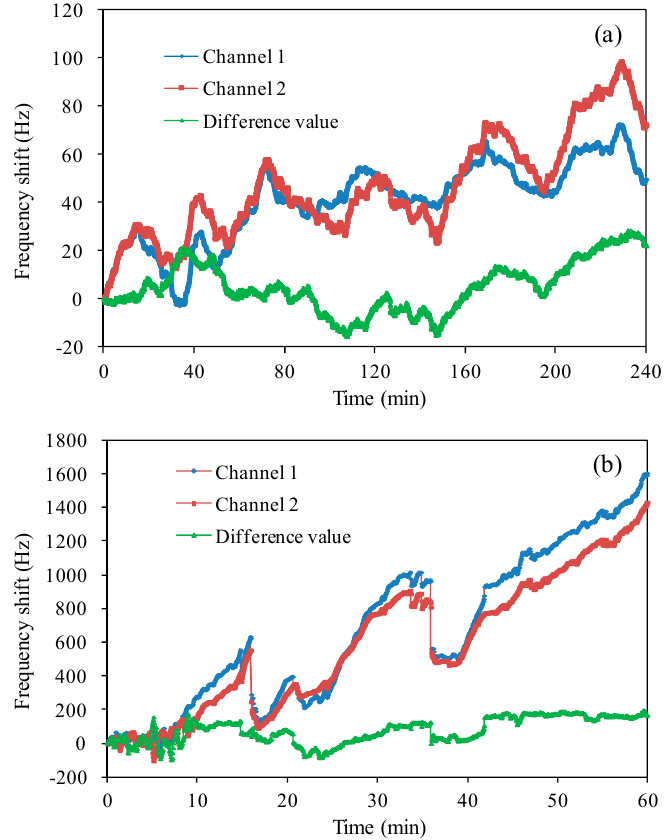
Figure 5. Measured frequency shift with oscillator circuit: ( a ) in air; ( b ) in pure water.